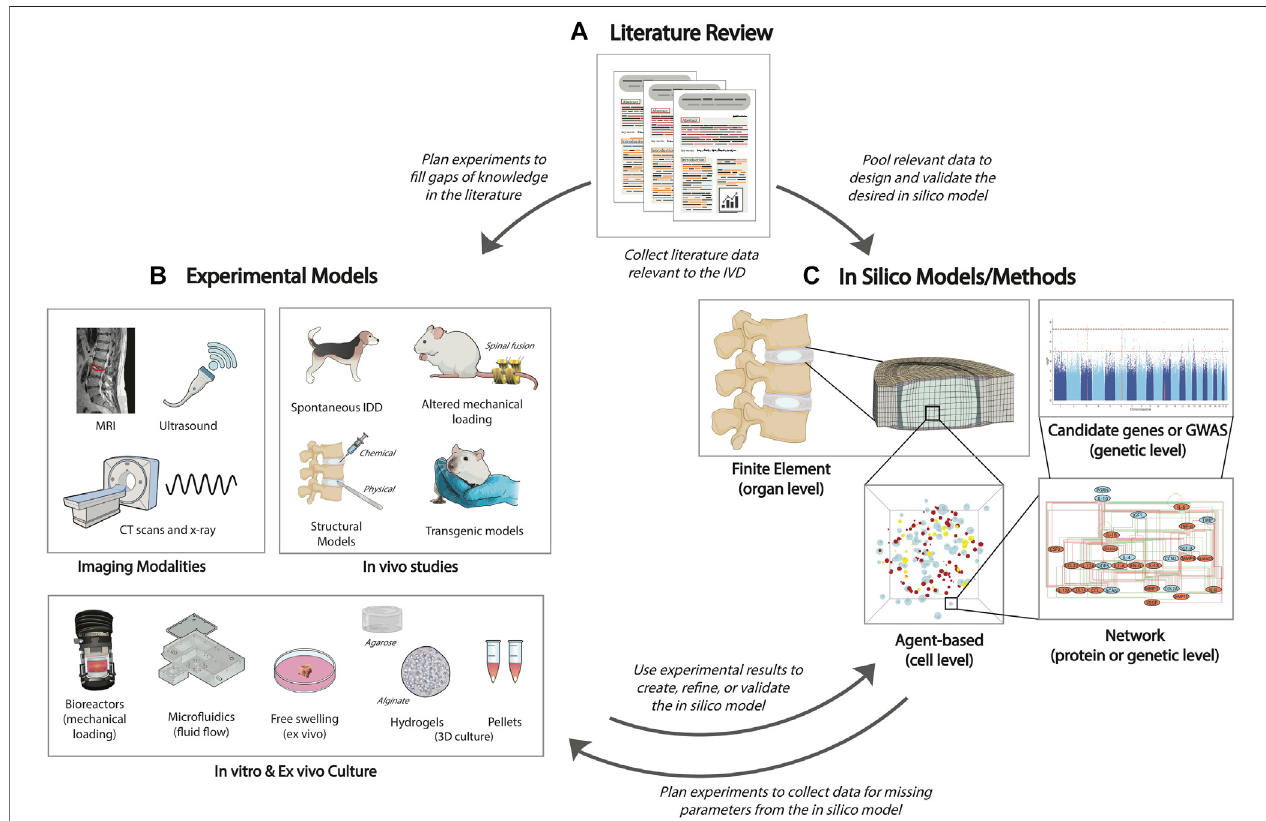
FIGURE4| Flowchartoftheintersectionofexperimentsandcomputationalmodeling. (A) First,aliteraturereviewisnecessarytodeterminethecurrentstateofthe research. Then, the researcher can either perform additional experiments to fi llgaps of knowledge inthe literature, or use published data tocreate an in-silico model. (B) There are many options for experimental model design, including use of imaging modalities to view the state of the IVD, in-vivo animal studies which better examine the complexity of IDD, bioreactors and micro fl uidic devices that allow the investigation of mechanical loading or fl uid fl ow in the IVD, and in-vitro/ex-vivo culture of the whole IVD or IVD cells from human or animal tissue. (C) In-silico models or methodologies can use published literature or additional experiments to provide deeper investigations into complex tissue (FEM), cell (ABM), protein (network modeling), and genetic responses (network modeling, GWAS) as well as explore interactions at multiplescaleswhichwouldbedif fi cultandexpensivetodoexperimentally.Thesemodelscanhelpidentifynovelparametersandinteractionsthatshouldbevalidatedor explored further through experiments.